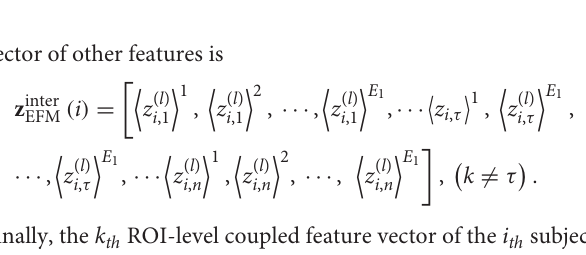
FIGURE 1 | A scheme of the proposed framework of two-level coupled interaction representation of neuroimaging